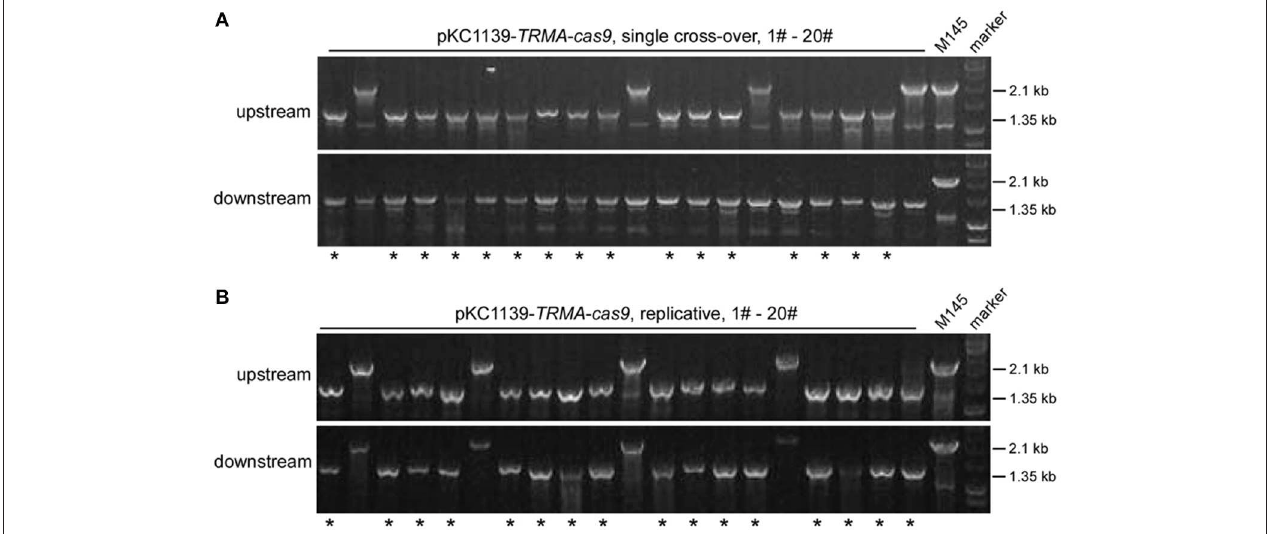
FIGURE 4 | actII-ORF4 deletion in S. coelicolor with engineered Cas9 and atpD overexpression from the pSG5 ori plasmid under induction conditions. The unedited transformants containing pKC1139-TRMA-cas9 in the single cross-over (A) or replicative form (B) from Figure 3B were simultaneously induced with thiostrepton, theophylline and blue light, and the genotype of twenty single colonies was investigated with diagnostic PCR as in Figure 2A . The successfully deleted strains were indicated with